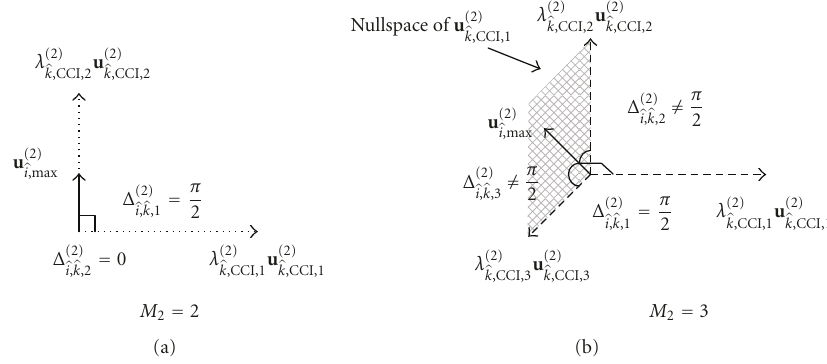
Figure 3: Design concept of the coordinated eigen-beamforming with geometrical interpretation.